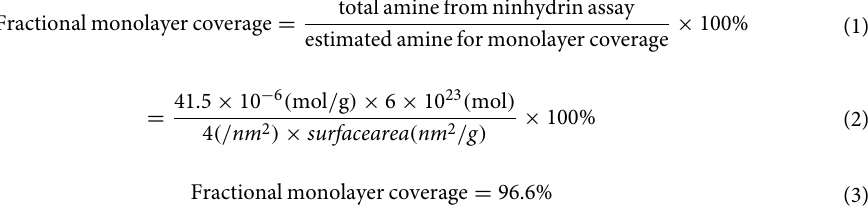
area (m 2 /g) of MNS is provided in SI.